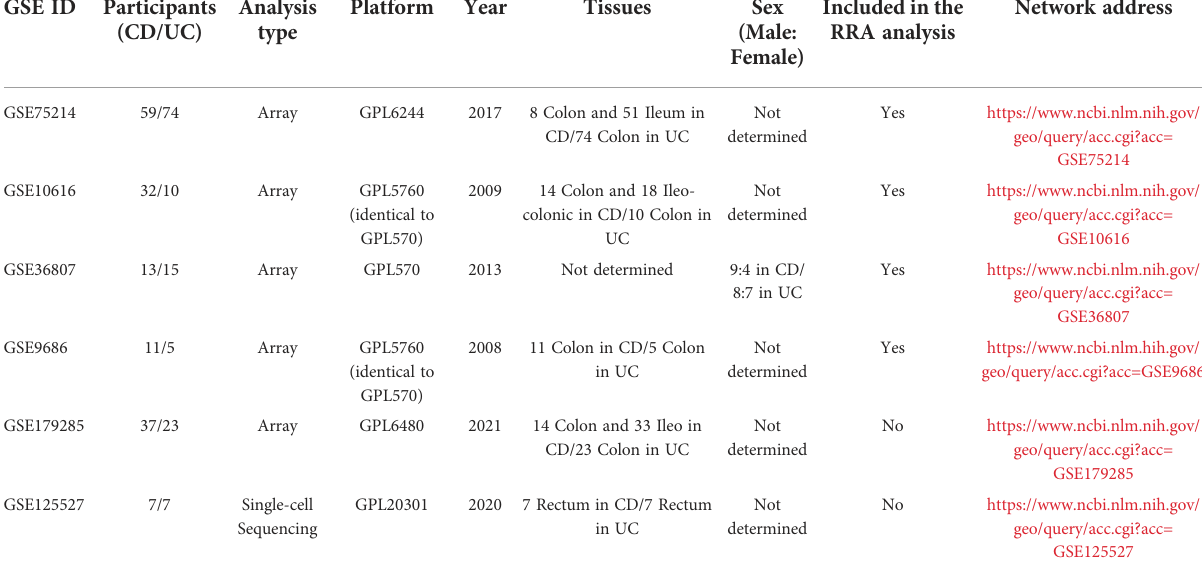
TABLE 1 Characteristic of the included microarray